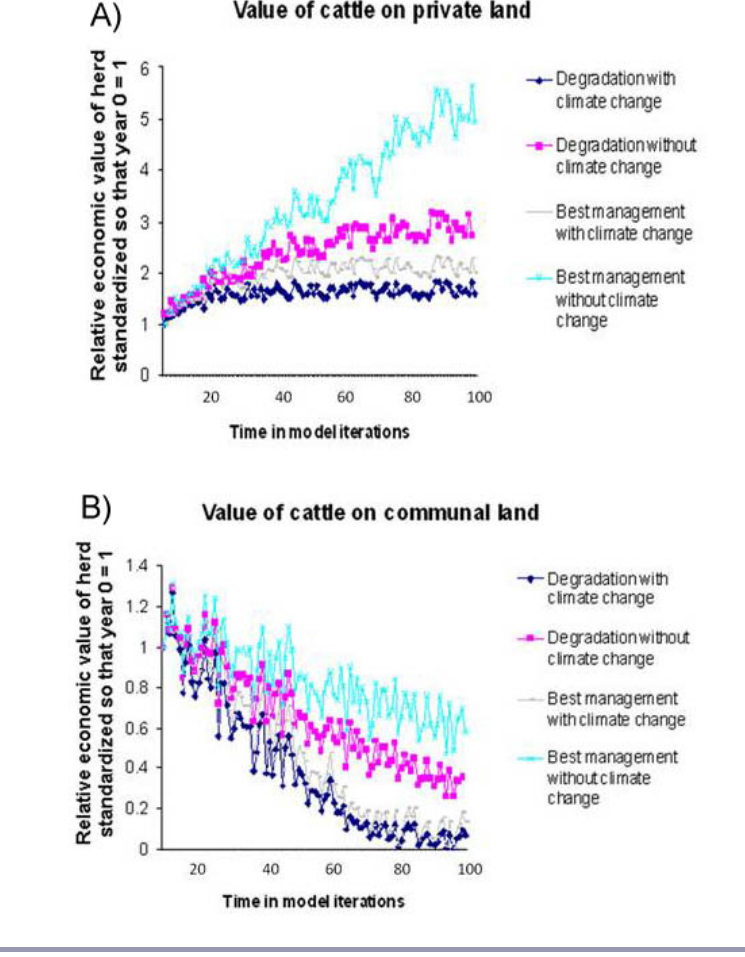
Fig. 5 . Management scenario options and their impacts on the value of cattle on A) private land and B) communal land across Southern Botswana (as per scenario assumptions in Table